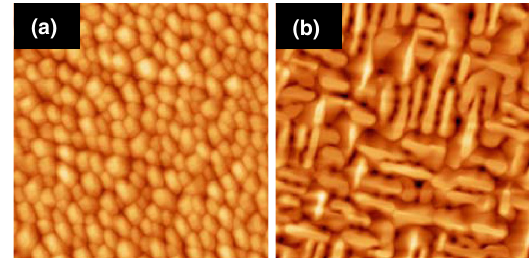
FIG. 3. Representative AFM scans for (a) Nb(100) and (b) Nb(110) surfaces. The scan size in both images is 2 (cid:3) m (cid:4) 2 (cid:3) m .